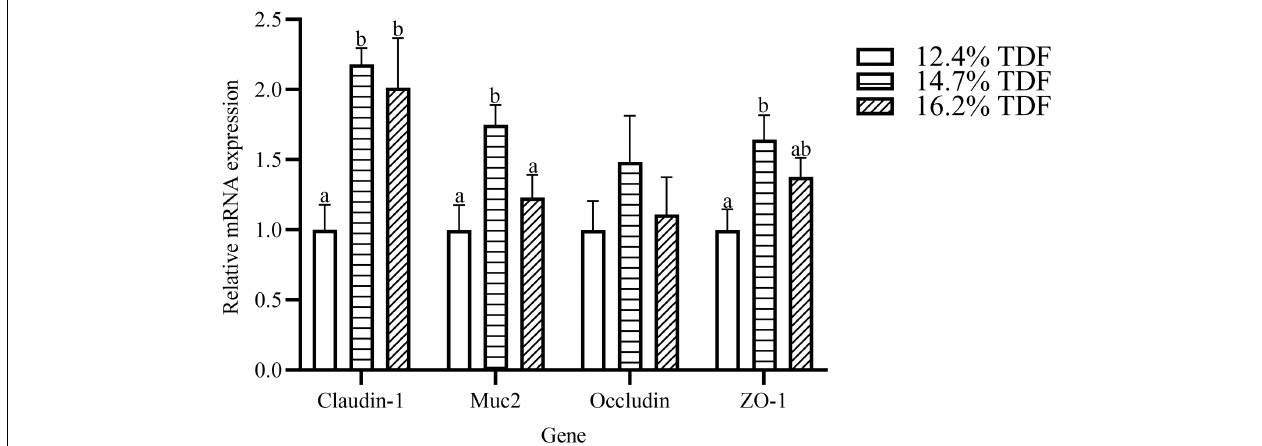
FIGURE 8 | Effects of total dietary fiber on the relative mRNA expression of cecal barrier function genes of White Pekin Ducks on day 35. a , b Means with different superscripts in the same index differ significantly ( n = 6, P < 0.05). 12.4% TDF, 12.4% total dietary fiber; 14.7% TDF, 14.7% total dietary fiber; 16.2% TDF, 16.2% total dietary fiber; Muc2, Mucin-2; ZO-1, Zonula